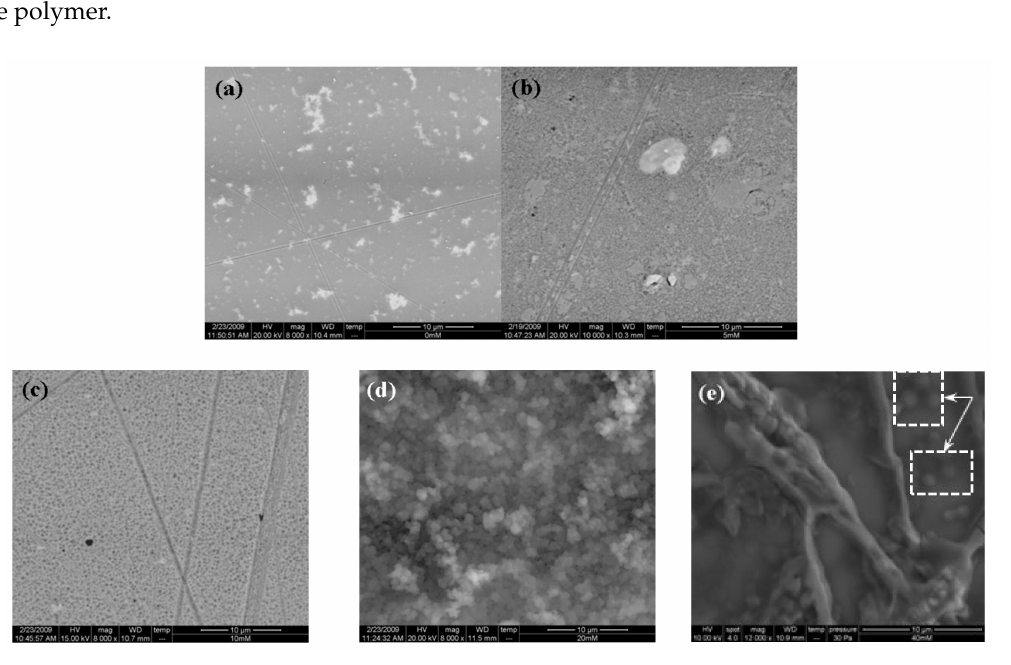
Figure 8. SEM images of the composite deposits obtained in presence of PSS at ( a ) 0, ( b ) 5, ( c ) 10, ( d ) 20, and ( e ) 40 mM. Scale: 10 µ